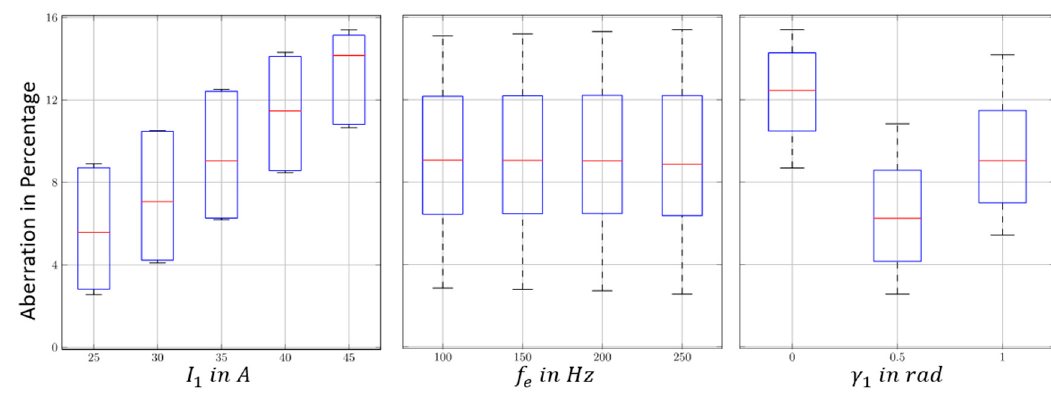
Figure 4. Distribution of the key indicator, e harm for the value of harmonics in torque.